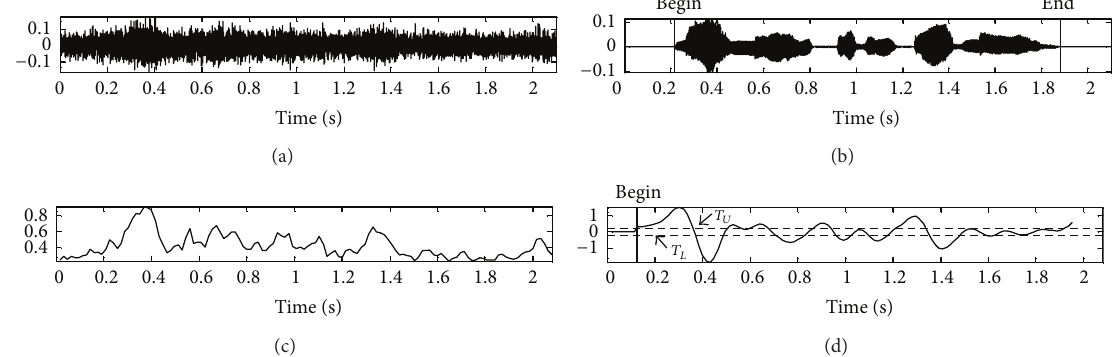
Figure 3: Results of endpoint detection based on frame energy and employing an edge detection filter in a car - noise environment: (a) noisy speech signal at SNR − 5 dB, (b) clean speech signal, (c) frame energy of signal (a), and (d) detection output of edge filter with state transition model ( 𝑇 𝐿 is lower threshold; 𝑇 𝑈 is upper threshold).